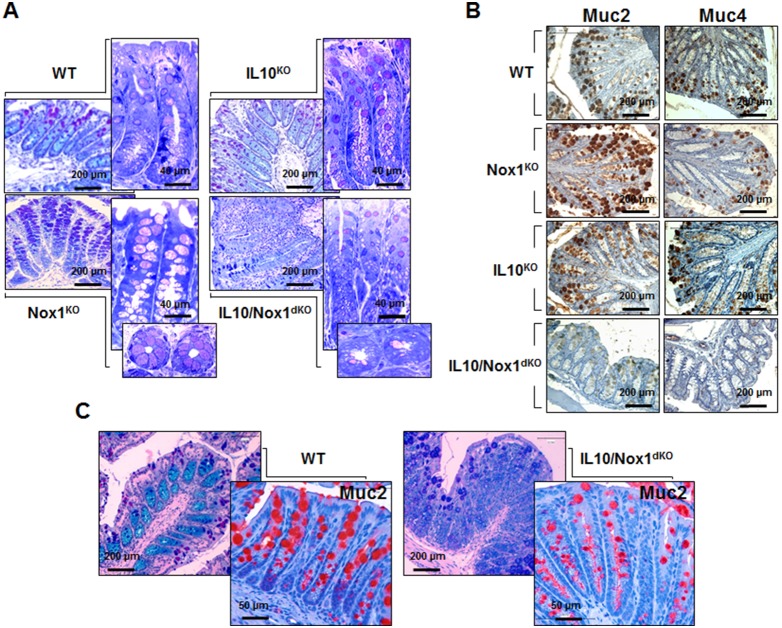
Altered goblet cells and mucin expression in IL10/Nox1dKO mice.(A) Representative sections of the distal colon of 7-week old WT (n = 10), Nox1KO (n = 10), IL10KO (n = 10), and IL10/Nox1dKO (n = 20) mice stained with AB/PAS. The distal colon of 7-week old WT (n = 5), Nox1KO (n = 5), IL10KO (n = 5), and IL10/Nox1dKO (n = 5) mice is shown both in transverse and longitudinal semi-thin sections. (B) Immunohistological analysis of Muc2 and Muc4 in distal colonic sections of 7-weeks old WT (n = 5), Nox1KO (n = 5), IL10KO (n = 5), and IL10/Nox1dKO (n = 5) mice. (C) Representative sections of the distal colon of 3-week old WT (n = 5) and IL10/Nox1dKO (n = 5) mice stained with AB/PAS (upper panels) or with anti-Muc2 antibody (lower panels).